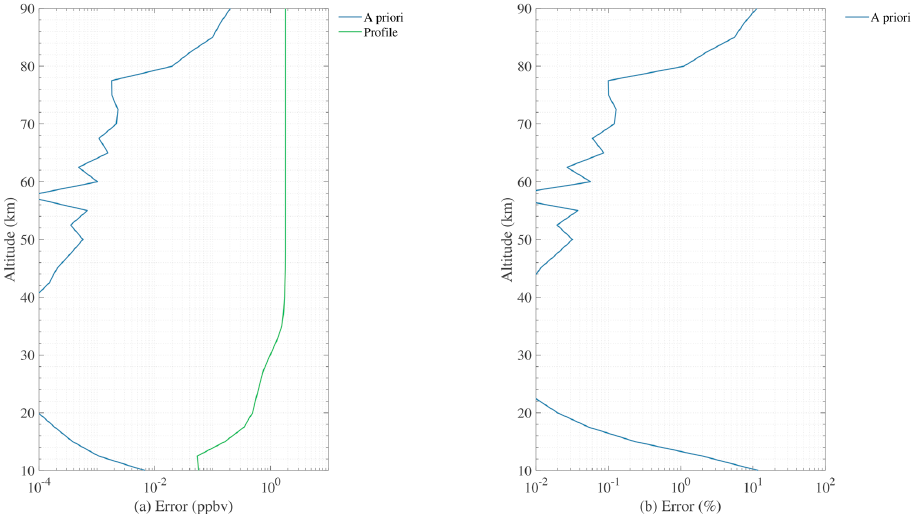
Figure 20. The HCl retrieval error induced by external error source: ( a ) absolute and ( b ) relative retrieval errors. The uncertainties assumed are summarized in Table 5.